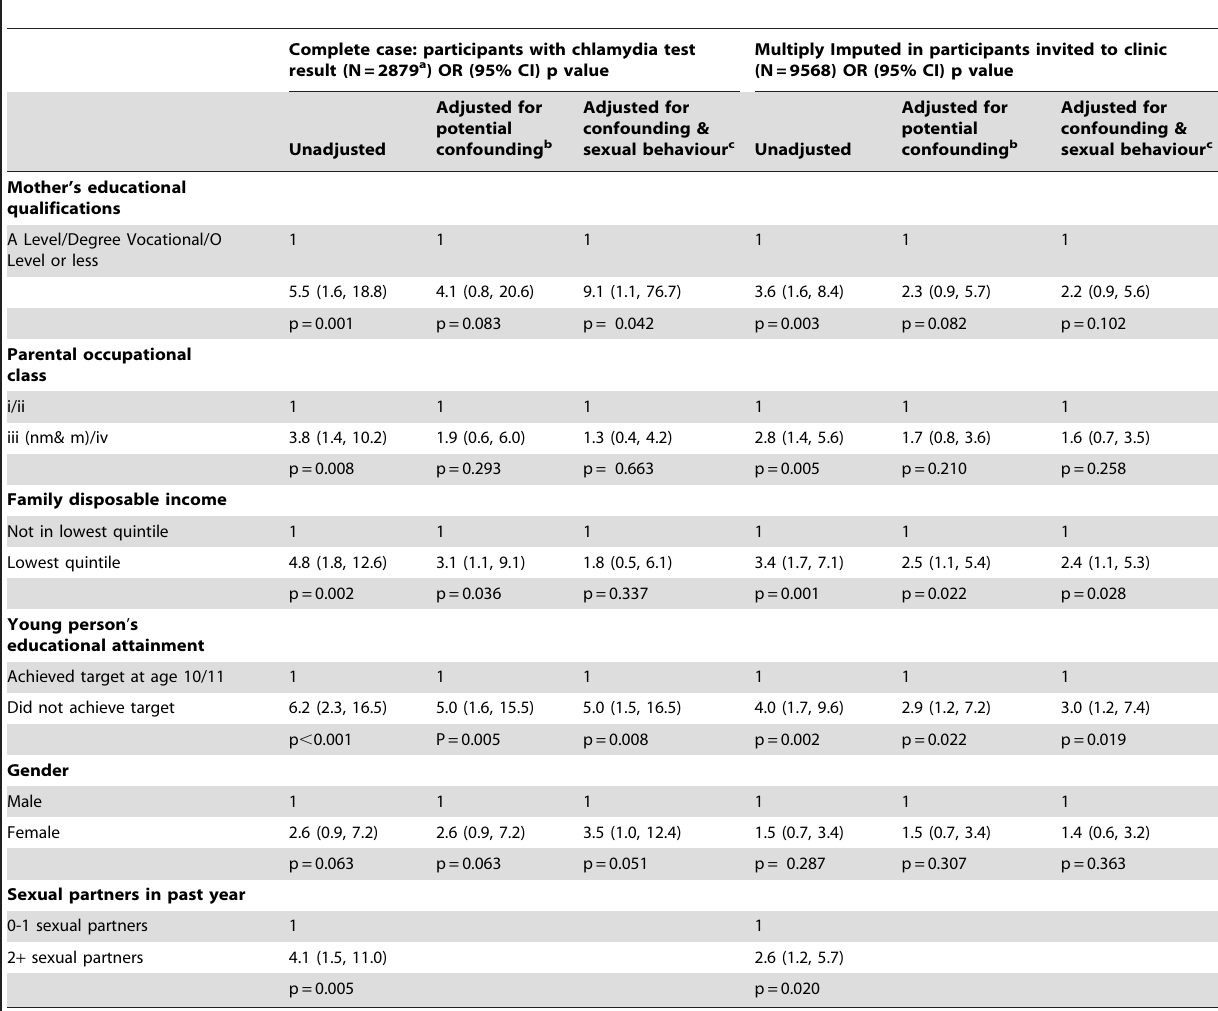
Table 5. Adjusted associations between chlamydia infection and gender, socioeconomic position, education and number of sexual partners, with complete case analysis and using three sensitivity tests examining missing